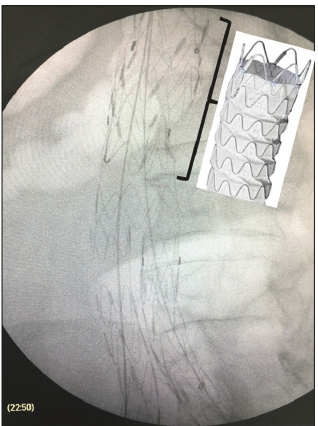
Figure 3: A 28 × 60 Ankura aortic extender was deployed to bridge the proximal remaining aortic neck with the migrated Talent